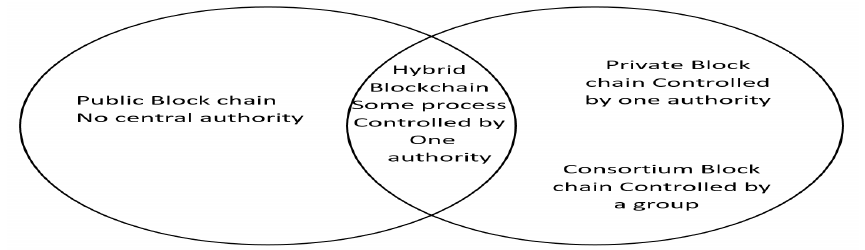
Figure 3. Types of